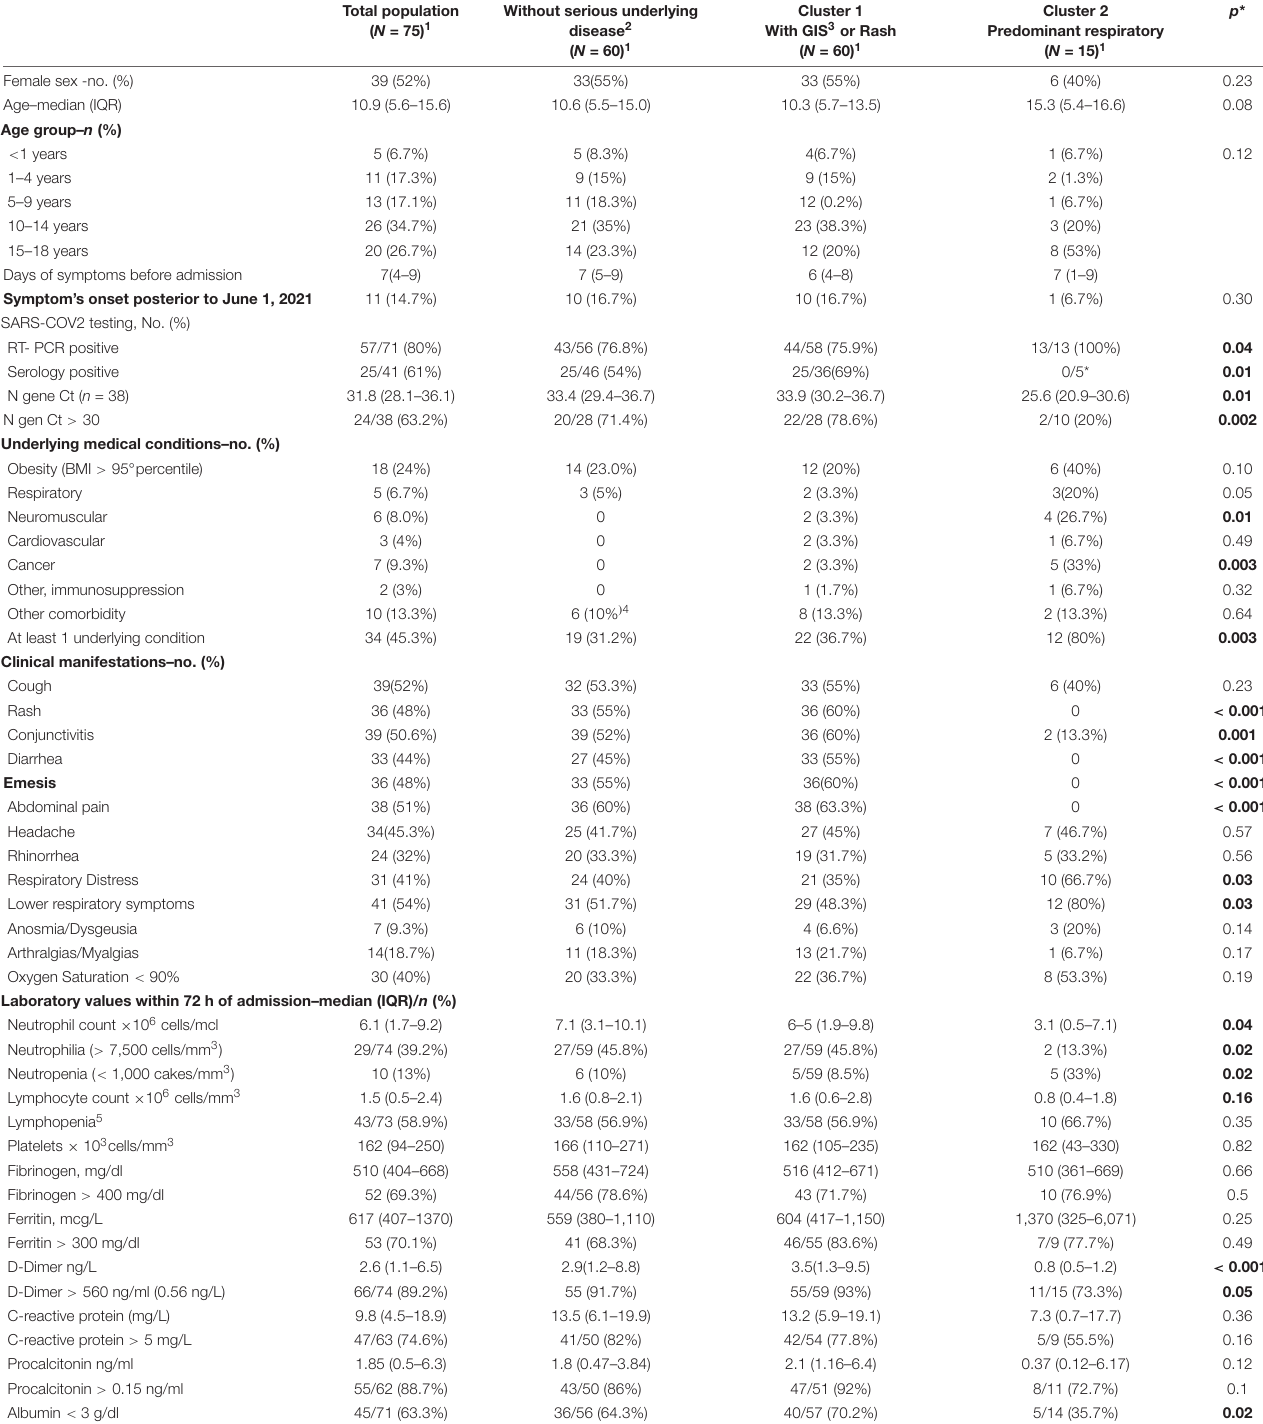
TABLE 2 | Clinical presentation of cases with